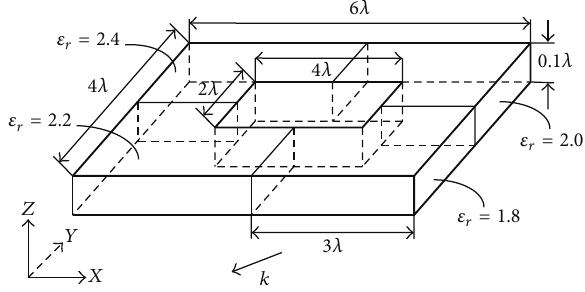
Figure 7: The dimensions of the hollow dielectric slab in Example